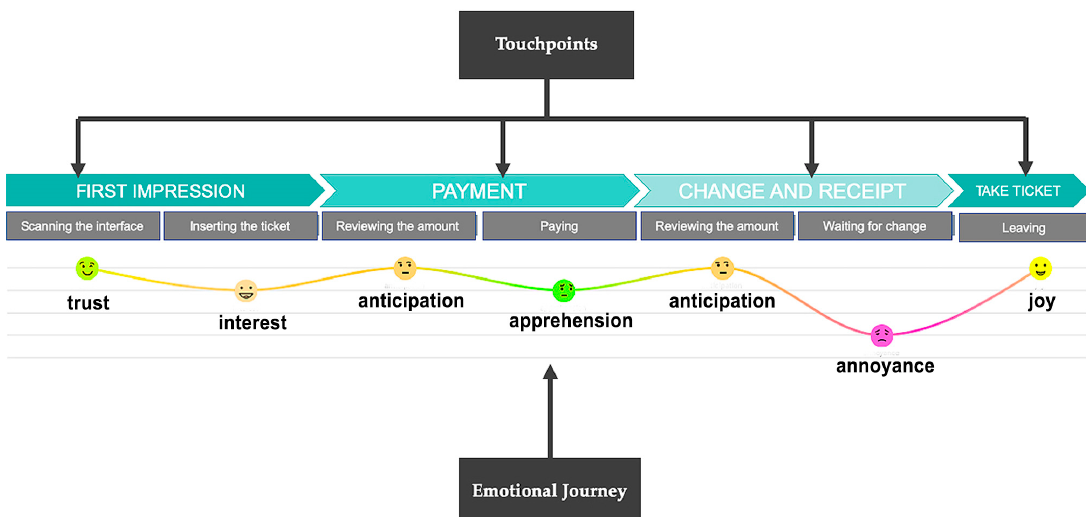
Figure 2. Customer Experience Map reflecting user experience during different touchpoints of interaction with interface.